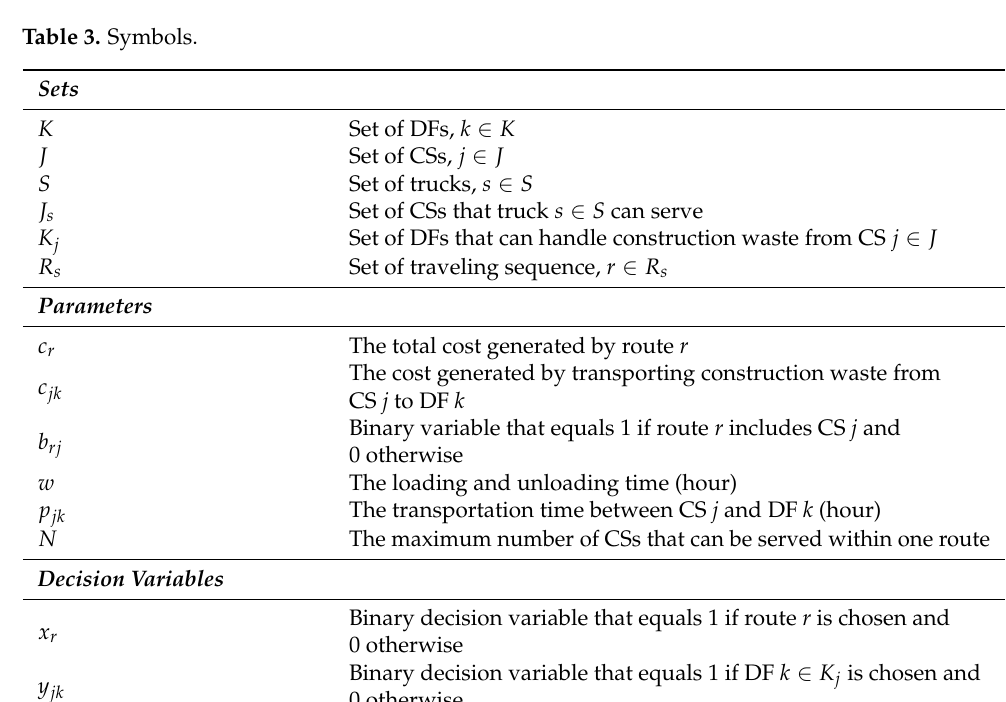
Figure 1. The transportation network. Table 3. Symbols .